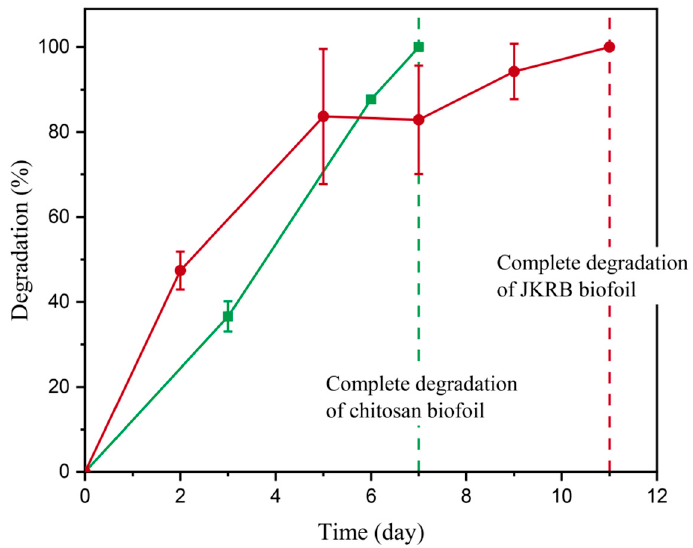
Figure 8. Degradation of chitosan (blank) biofoil (green curve) and JKRB biofoil (red curve) in industrial compost.